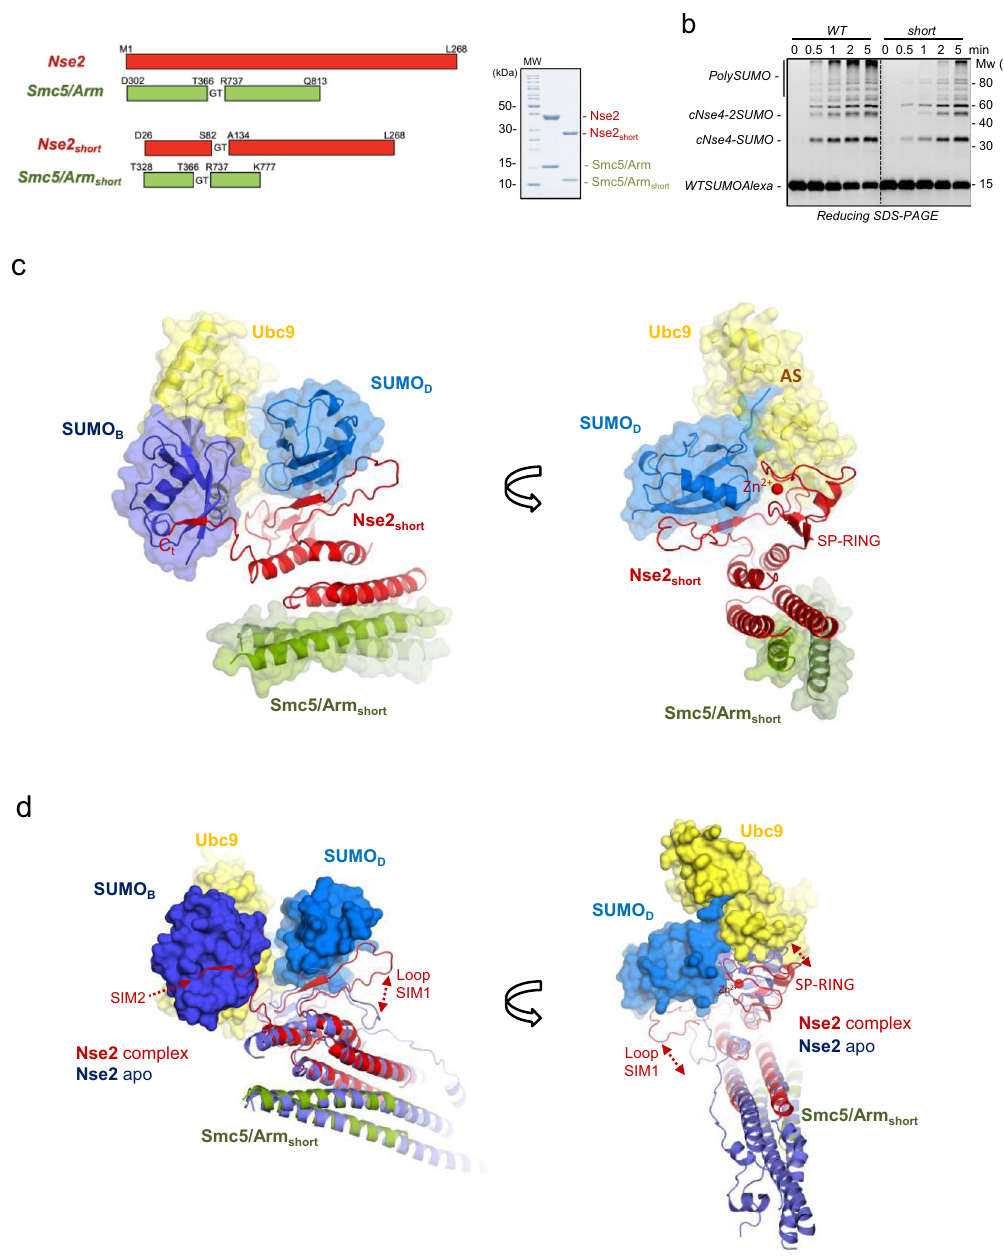
Fig. 1 Structure of yeast Nse2/Smc5 in complex with the E2-SUMO thioester mimetics. a Schematic representation of the engineered short form of Nse2 and Arm/Smc5 coiled-coil. b Multiple-turnover SUMOylation reactions using Nse2/Arm-Smc5 and short Nse2/Arm-Smc5. SDS-PAGE represents one of three technical replicates. c Side views of the short Nse2/Arm-Smc5 E2-SUMO D SUMO B complex. Each subunit is color coded. The crystal asymmetric unit contained one complex composed of Smc5/Nse2 short , Ubc9-SUMO D thioester mimetic and SUMO B . d Side views of the structural alignment of short Nse2/Arm-Smc5 E2-SUMO D SUMO B complex with Nse2/Arm-Smc5 apo complex (3HTK). Both structures were aligned using the Arm/Smc5 coiled-coils domains. The superimposition reveals a major conformational change of loop SIM1 to interact with SUMO D and the C-terminal tail of Nse2 (named SIM2) to interact with SUMO B to the WT Smc5/Nse2, at least for the single cNse4 conjugation stable isopeptidic bond located in a similar position as the natural (cNse4-SUMO), only high molecular conjugates are substantially E2~SUMO D thioester bond. Previous studies and our experimental data indicated that a diminished (Fig. 1b). Initially, crystals of Smc5/Nse2 short -SUMO B fusion in complex to E2-SUMO D thioester mimetics diffracted only SUMO B fused to the C-terminus of Nse2 can stabilize the complex through non-covalent interactions with the E2 backside surface. Our to 5.5 Å. However, under similar conditions, the crystals diffracted initial crystallization trials of Ubc9-SUMO thioester mimetic in up to 3.3 Å when non-fused Smc5/Nse2 short was mixed with free SUMO B (Supplementary Table 1). complex with Smc5/Nse2 or fused Smc5/Nse2-SUMO B were unsuccessful. However, we engineered a shorter Nse2, containing The asymmetric unit contained one complex composed by the SP-RING domain bound to a shorter Smc5/Arm coiled-coil Smc5/Nse2 short , E2-SUMO D thioester mimetic, and SUMO B attached to the E2 backside (Fig. 1c). The structure unveils an (Fig. 1a). The E3 ligase activity of the Smc5/Nse2 short is comparable